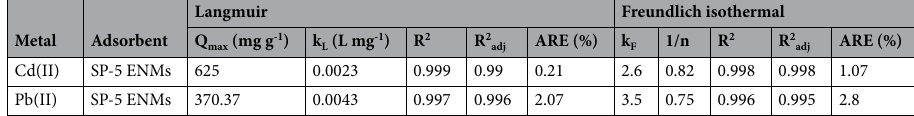
Table 5. Parameters of Langmuir and Freundlich models for Cd(II) and Pb(II) adsorption isotherm on SP-5 ENMs.